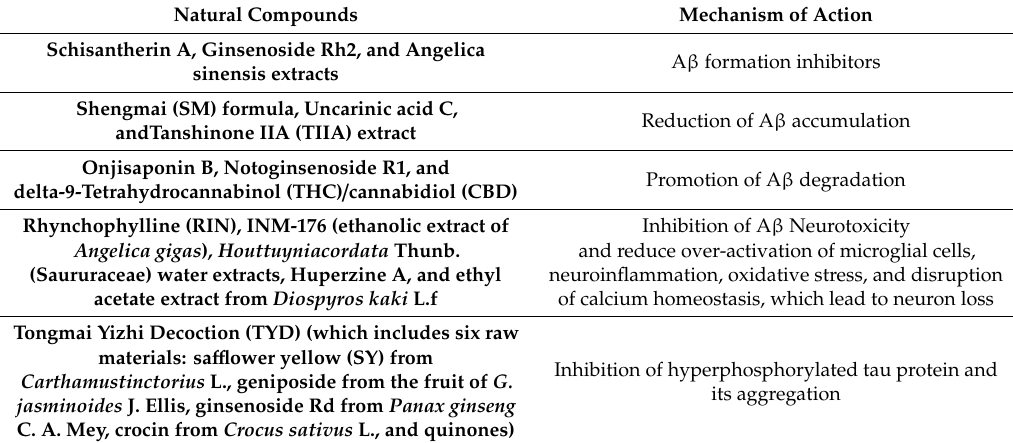
Table 2. Natural compounds used in folk medicine and their mechanism of